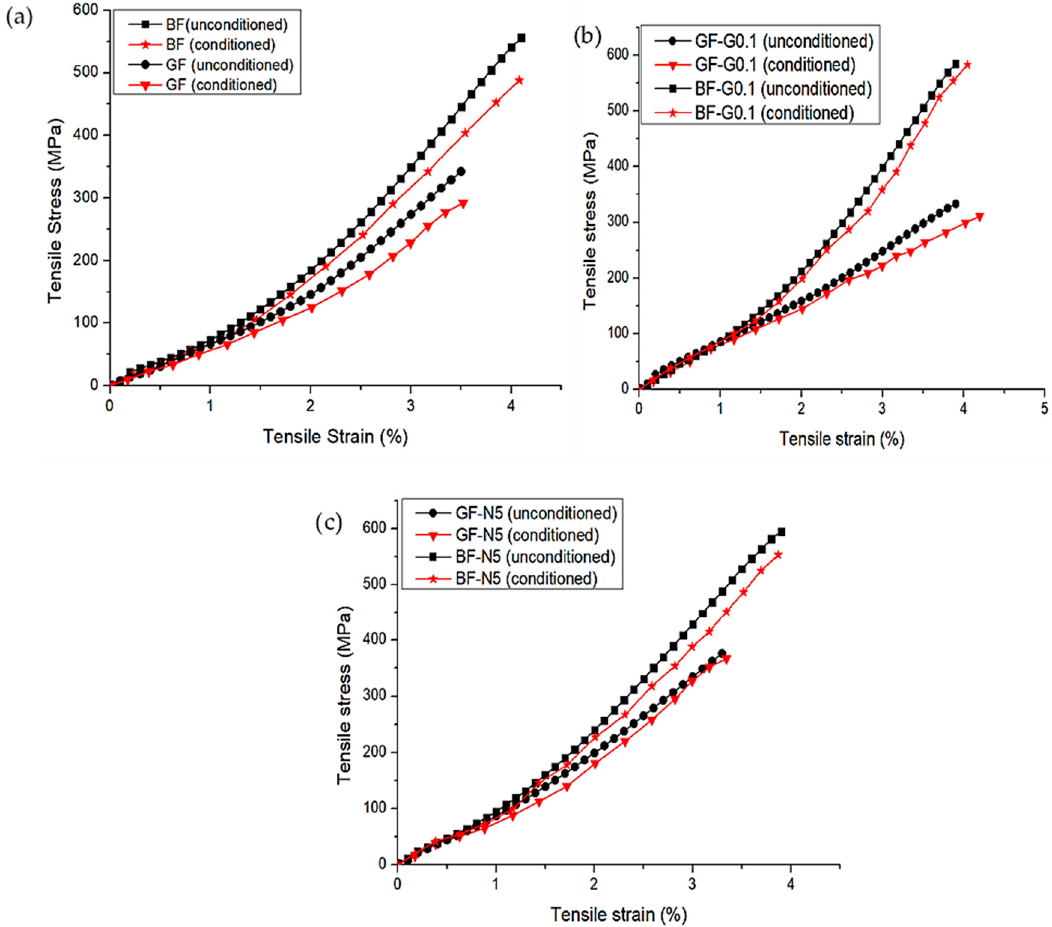
Figure 6. Tensile stress − strain response of unmodified and nanomodified specimens for conditioned and unconditioned systems of ( a ) unmodified FRP composites, ( b ) GNP modified FRP composites, and ( c ) Nanosilica modified FRP composites.